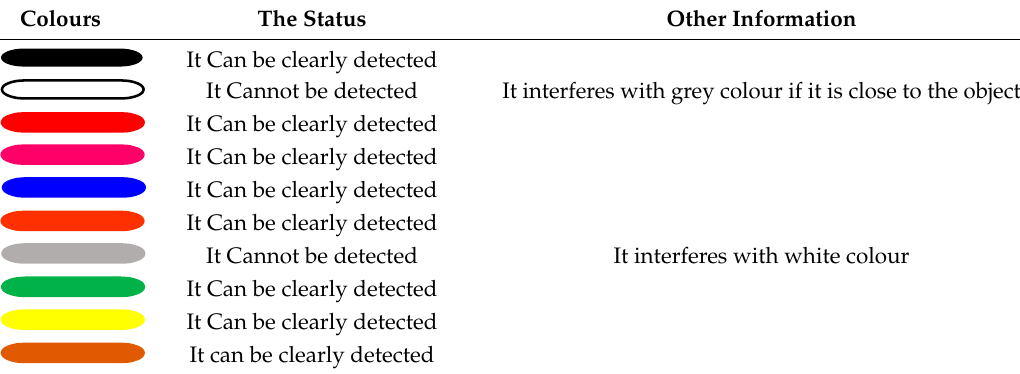
Figure 2. Detection of the red coloured objects. Table 1. List of colours and their status.